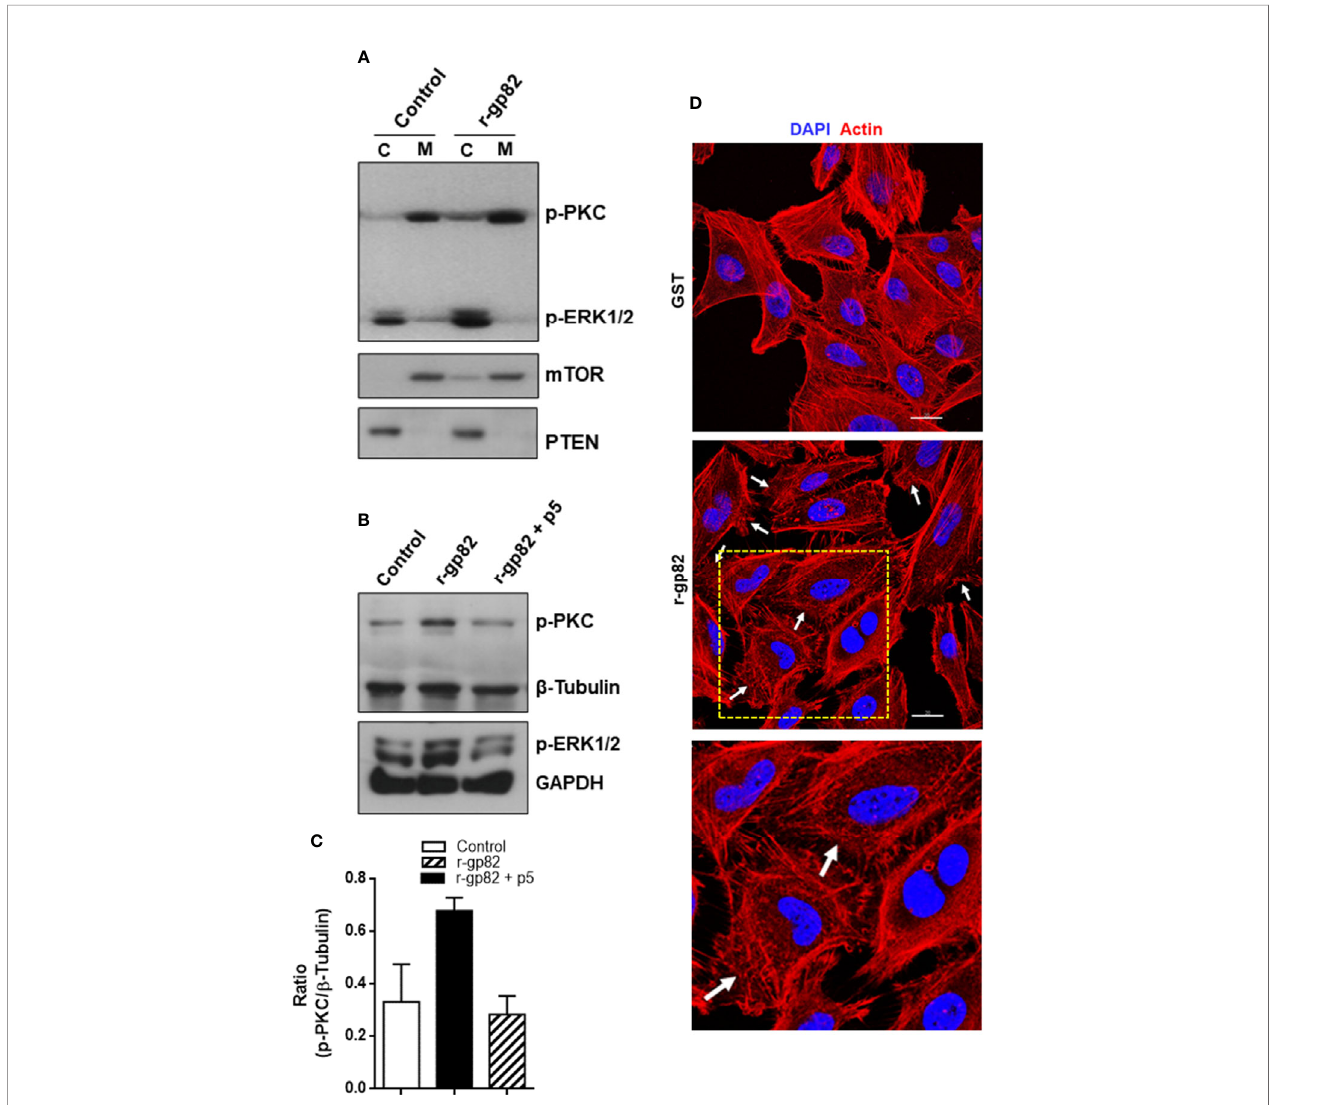
FIGURE 5 | Blockage of gp82-induced activation of host cell PKC and ERK1/2 by peptide p5. (A) HeLa cells were incubated for 30 min in absence or in the presence of r-gp82. The cytosolic (C) and membrane (M) fractions were analyzed by Western blotting using antibody to phospho-PKC and to phospho-ERK1/2. Note the increased phosphorylation levels of PKC and ERK1/2 upon incubation with r-gp82, and the detection of PKC and ERK1/2 predominantly in the membrane and cytosolic fractions, respectively. (B) HeLa cells were incubated for 30 min with r-gp82 in absence or in the presence of peptide p5. The western blot was revealed with antibodies directed to: phospho-PKC, phospho-ERK1/2, b -tubulin or GAPDH. Note the impairment of gp82-induced PKC and ERK1/2 activation by peptide p5. (C) Densitometry analysis of Western blots were performed. Values are the means ± SD of three independent assays. (D) HeLa cells were incubated for 30 min in absence or in the presence of r-gp82 and then processed for visualization of actin cytoskeleton (red) and nucleus (blue). Scale bar = 20 µm. Note the disrupted cortical F-actin in cells incubated with r-gp82 (white arrows). To facilitate visualization, a magni fi ed image from the framed area (square) is also